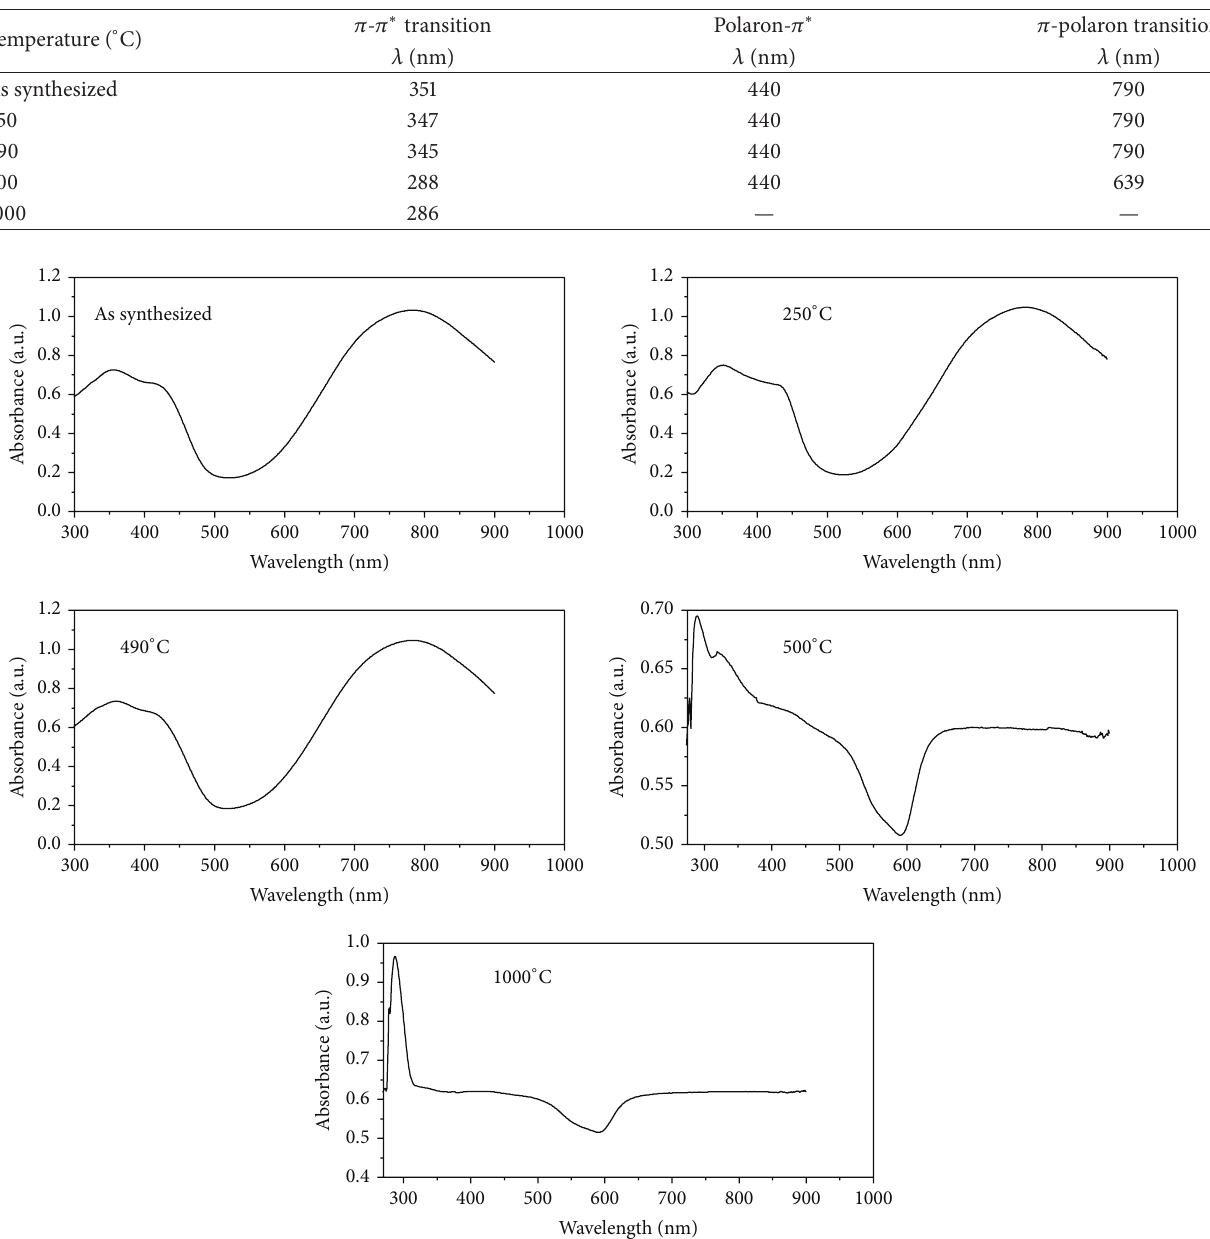
Table 2: Band positions ( 𝜆 ) in the UV-Vis spectra of emeraldine salt.